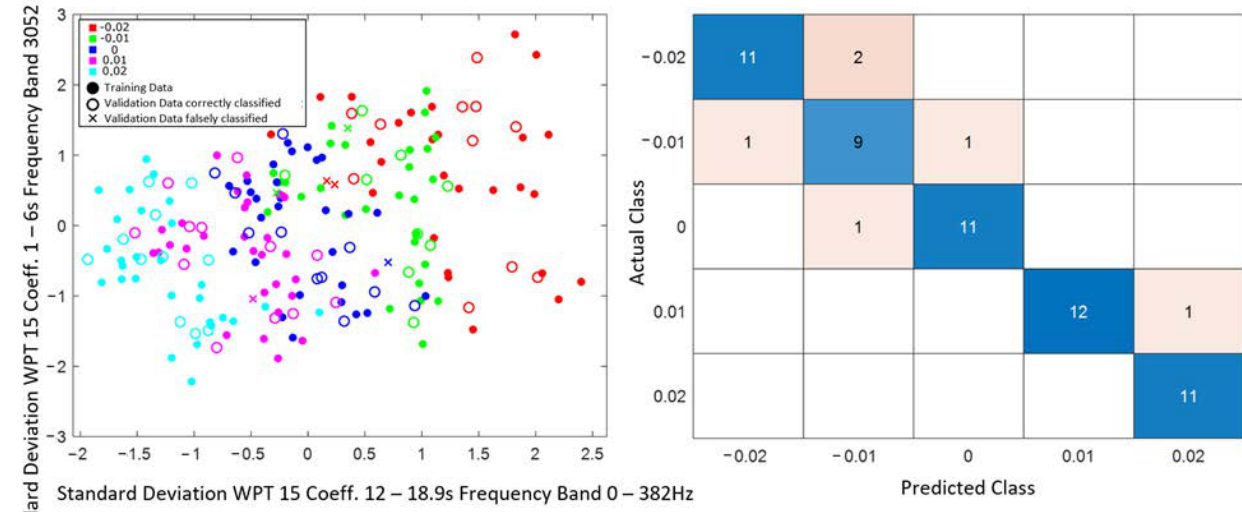
Figure 11. Best two features and confusion matrix of SVM for radial-feed classification (feature selection: MANOVA, features from raw signal and WPT with 15